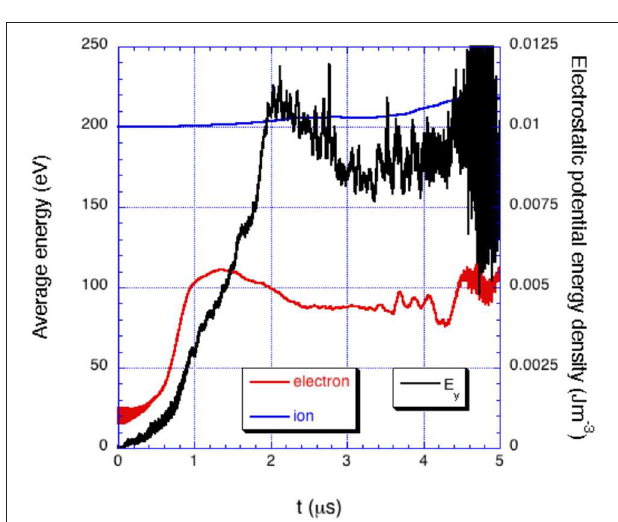
FIGURE 4 | Electron (red curve), ion (blue curve) averaged energy and electrostatic potential energy density (black curve) in the simulation up to t µ s. Results refer to the reference case using physical parameters reported in Table 1